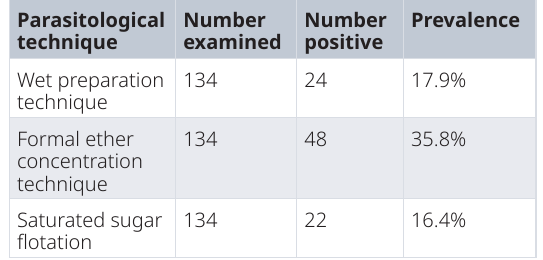
Table 5. Correlation between parasitological